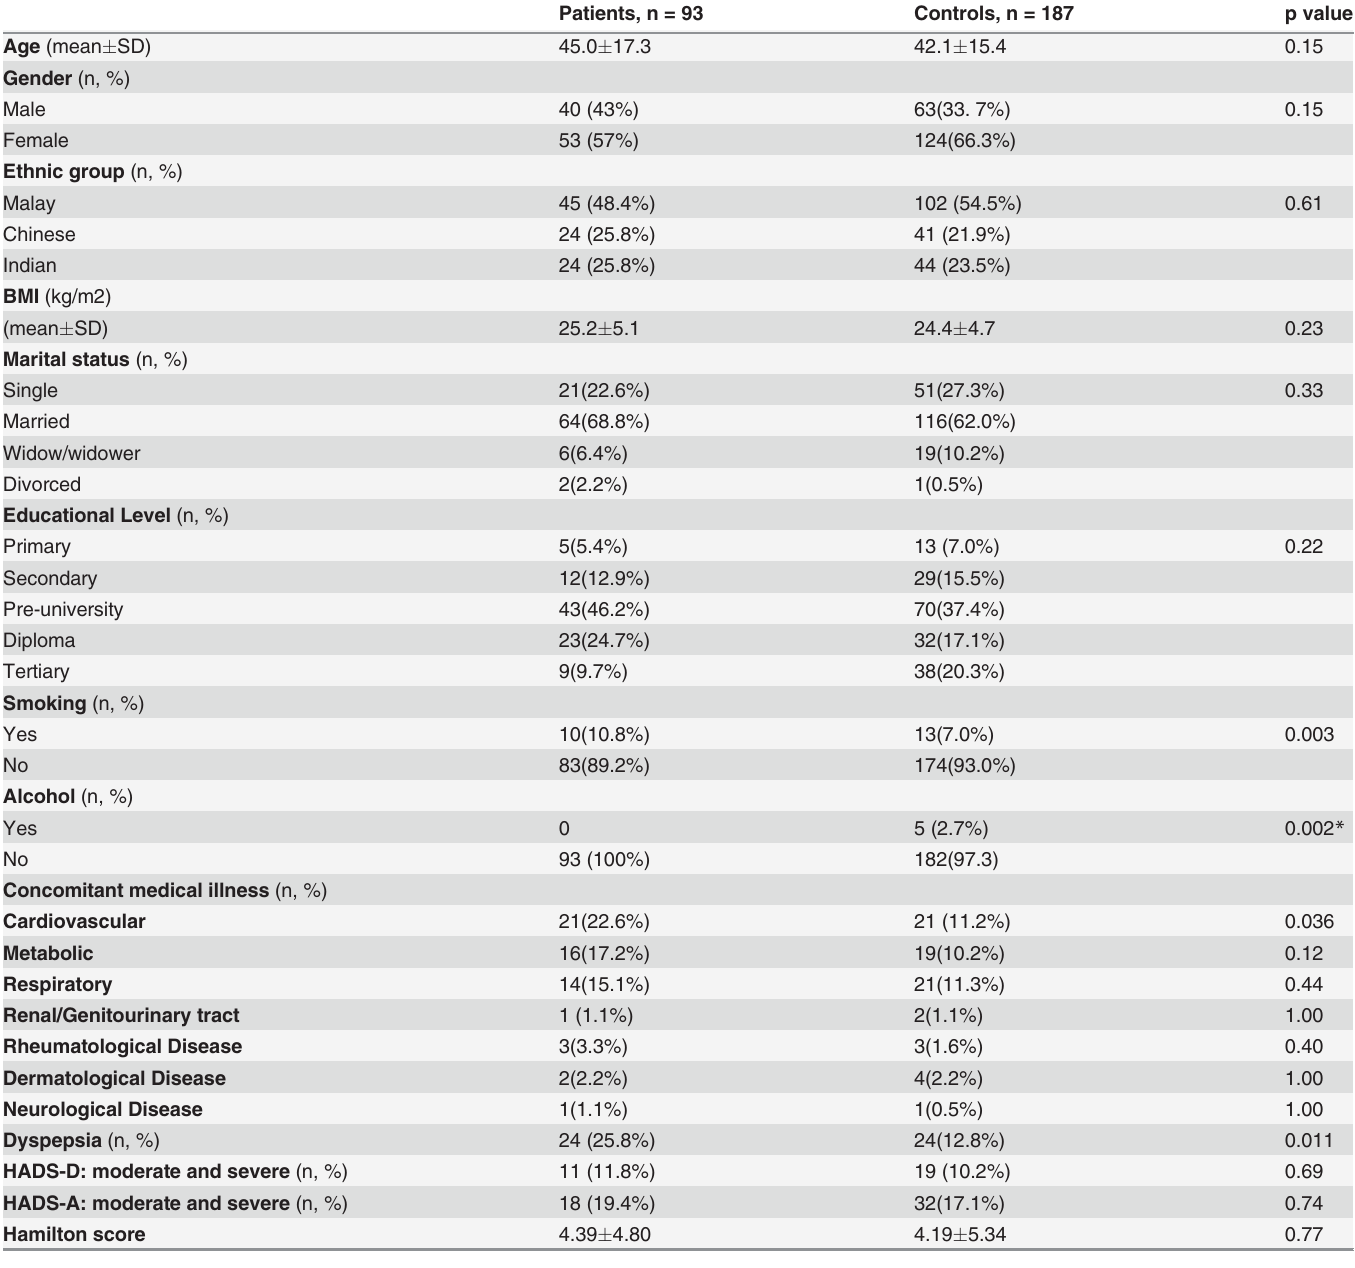
Table 1. Baseline characteristics of subjects with headache and non-headache